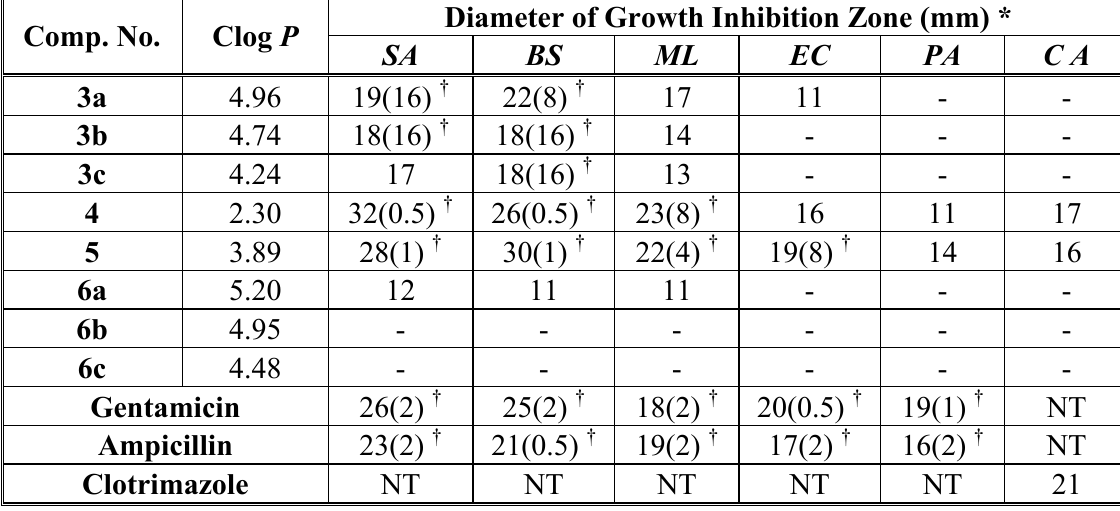
Table 1. Antimicrobial activity of compounds 3a – c , 4 , 5 and 6a – c (200  g/8 mm disc),